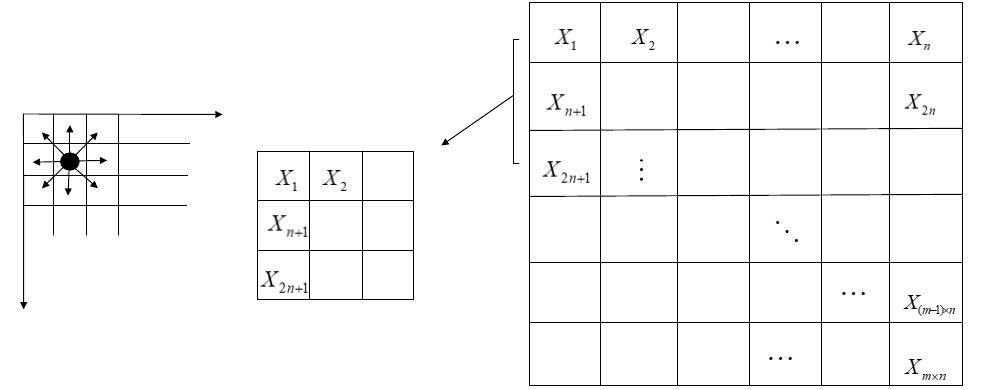
Figure 14. The eight-neighborhood traversal.